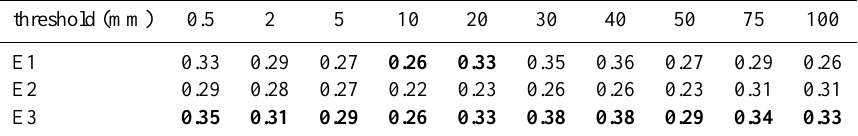
Table 3. Brier Skill Score computed for different precipitation thresholds for the E1, E2 and E3 ensembles. The reference is the deterministic AROME forecast. Bold numbers for each threshold show the best performing ensemble. threshold